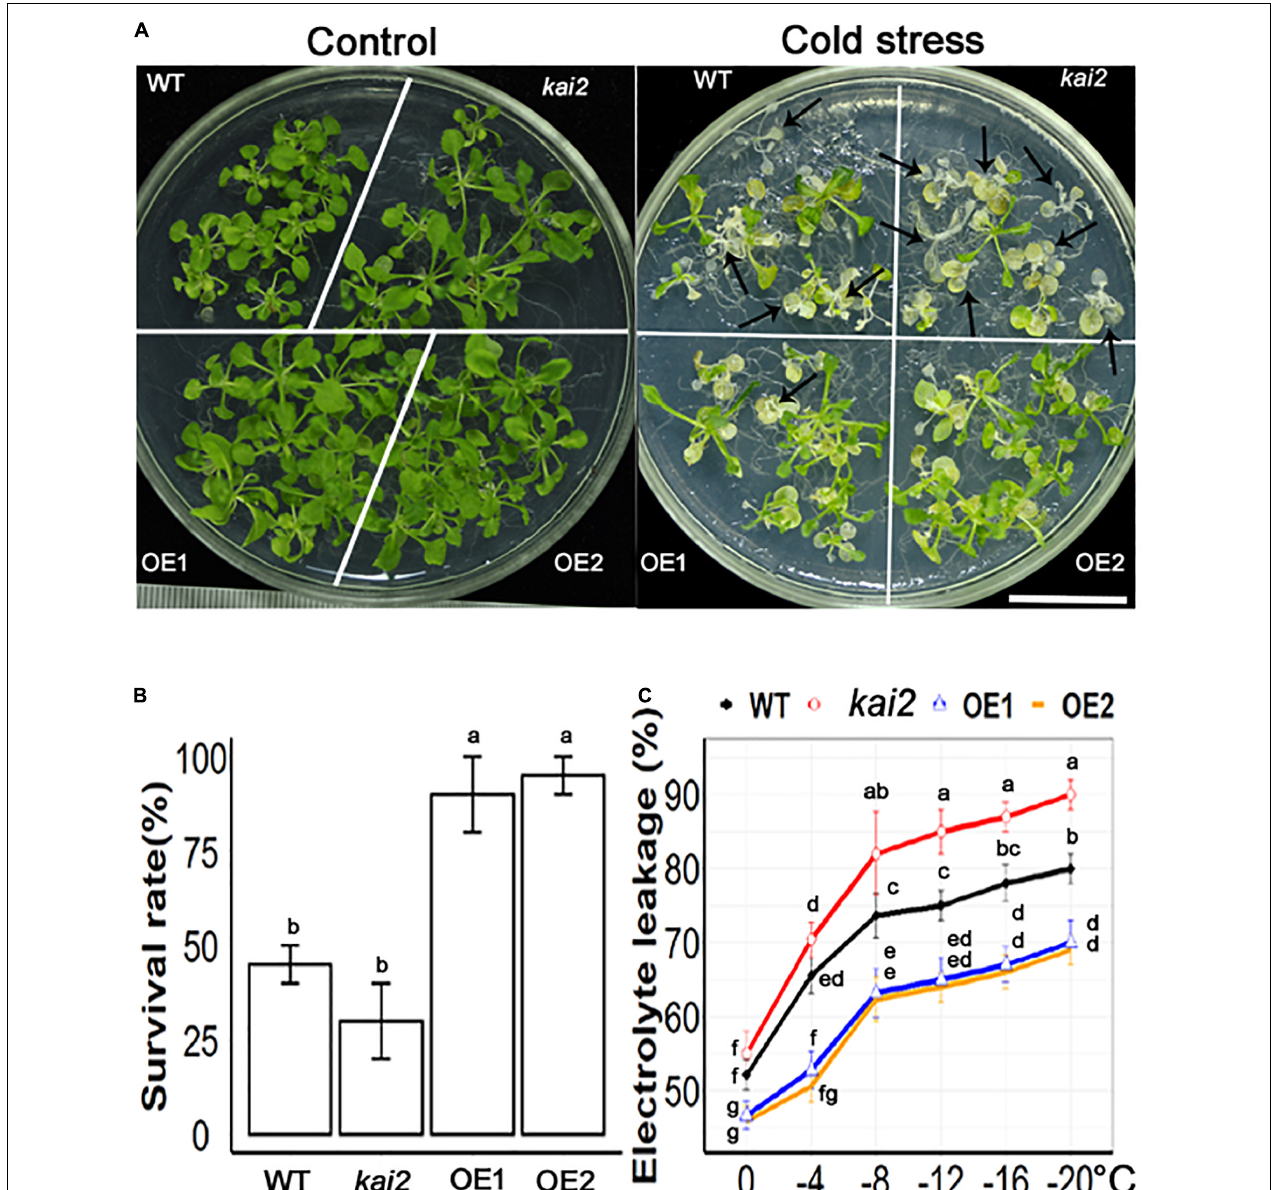
FIGURE 2 | SsKAI2 alleviated cold stress in Arabidopsis. (A) Phenotypes of wild-type (WT), Atkai2 , and SsKAI2 (OE1 and OE2) Arabidopsis at room temperature and under cold stress ( − 20 ◦ C). Pictures were taken after ten days after cold stress, white bar = 2cm. (B) Statistical presentation of survival rate after cold stress. (C) Electrolyte leakage was measured by subjecting 15-day-old plants at 0 − , – 4 − , – 8 − , – 12 − , – 16 − , and − 20 ◦ C for an hour. One-way ANOVA was used to analyzed all data, and HSD Tukey’s test was used to perform multiple comparisons at P < 0.05 significant level ( n = 5 in survival rate measurement and n = 3 in electrolyte leakage test). Bars or points with uncommon letters showing significant difference at P <